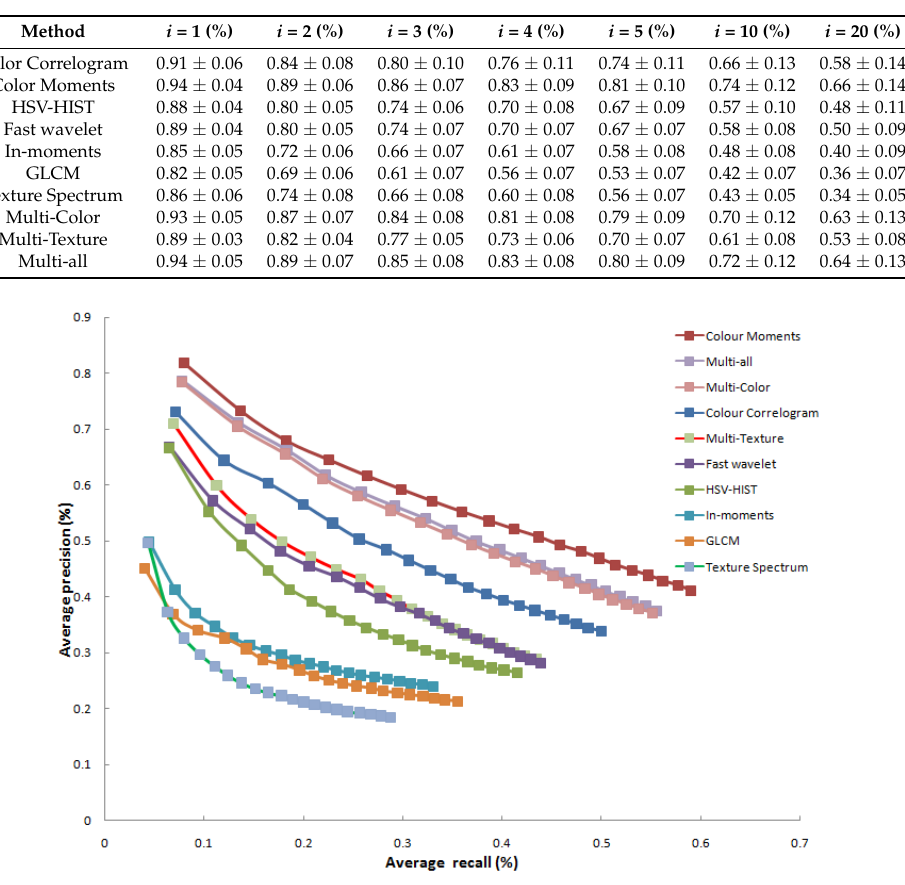
Figure 6. Comparison of the average PVR (precision-recall) curve for different